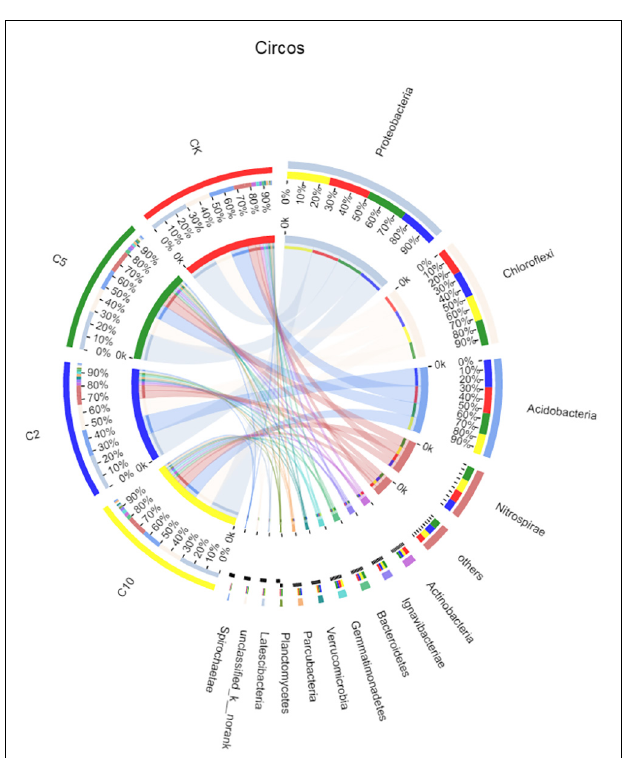
FIGURE 4 | Relationships between samples and phyla are shown in Circos figures. The CK, C2, C5, and C10 is representative of the sample from soil processed with 0, 0.2, 0.5, and